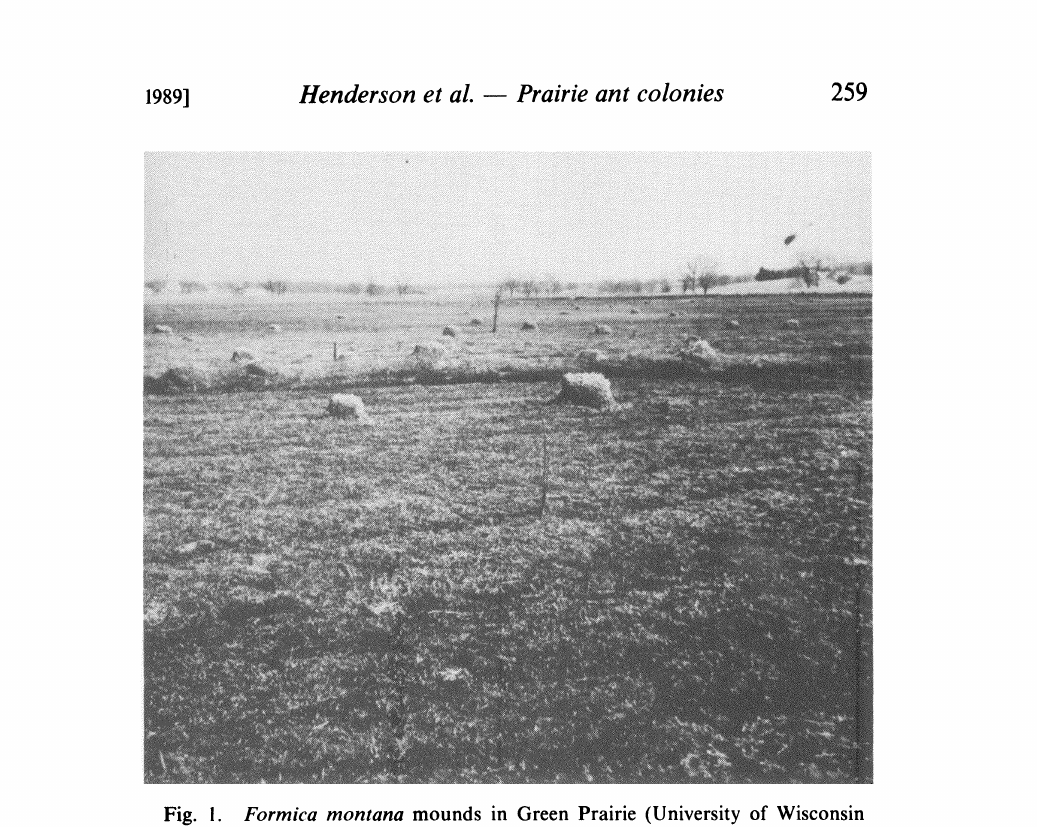
Fig. I. Formica montana mounds in Green Prairie (University of Wisconsin Arboretum, Madison, WI), after a prairie fire. Photograph taken in